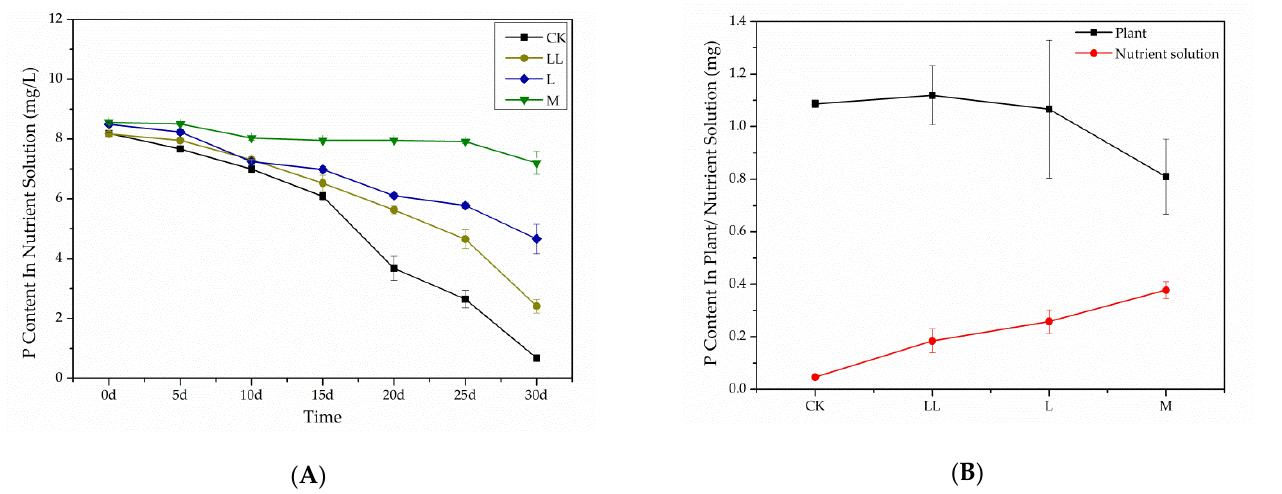
Figure 9. Changes in phosphate concentration in nutrient solution over time ( A ), and changes of total phosphorus in Arabidopsis thaliana plants treated with Eupatorium adenophorum aqueous extracts and the residual phosphorus in nutrient solution ( B ). Abbreviations: CK–control; LL–treated by 6.25% aqueous extract; L–treated by 12.5% aqueous extract; M– treated by 25% aqueous extract. Error bars represent standard error (SE).